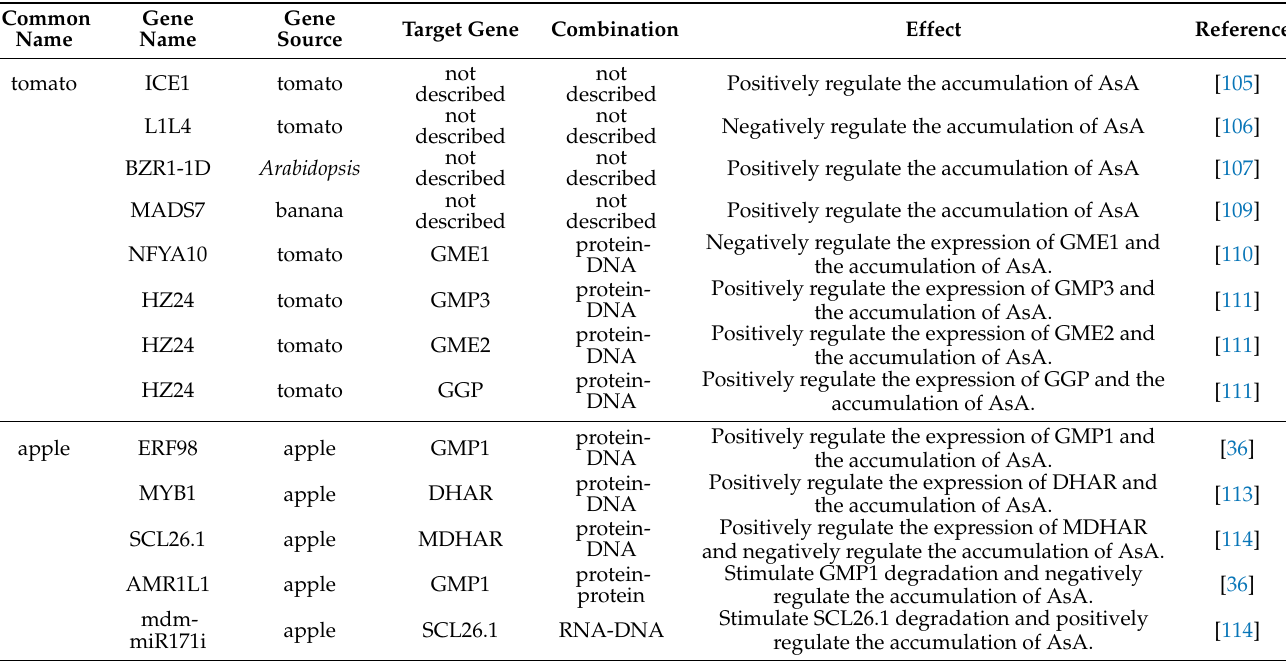
Table 3. Regulation of AsA metabolism-related genes at the transcriptional and protein